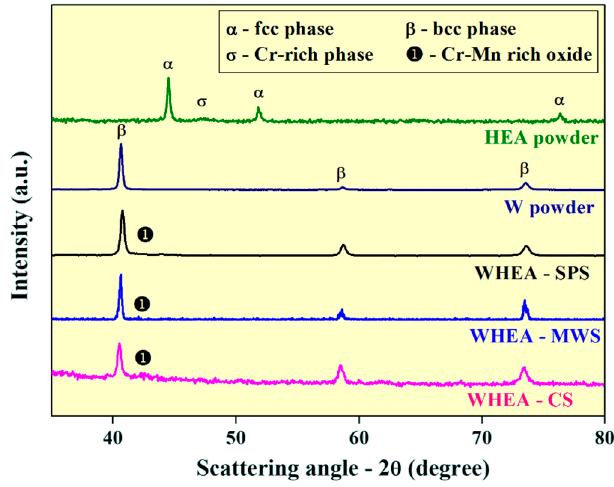
Figure 3. X-ray diffraction patterns of pure tungsten (W) powder, mechanically alloyed CoCrFeMnNi high-entropy alloy powder and consolidated tungsten heavy high-entropy alloys (WHHEA) samples prepared by conventional, microwave and spark plasma sintering processes.